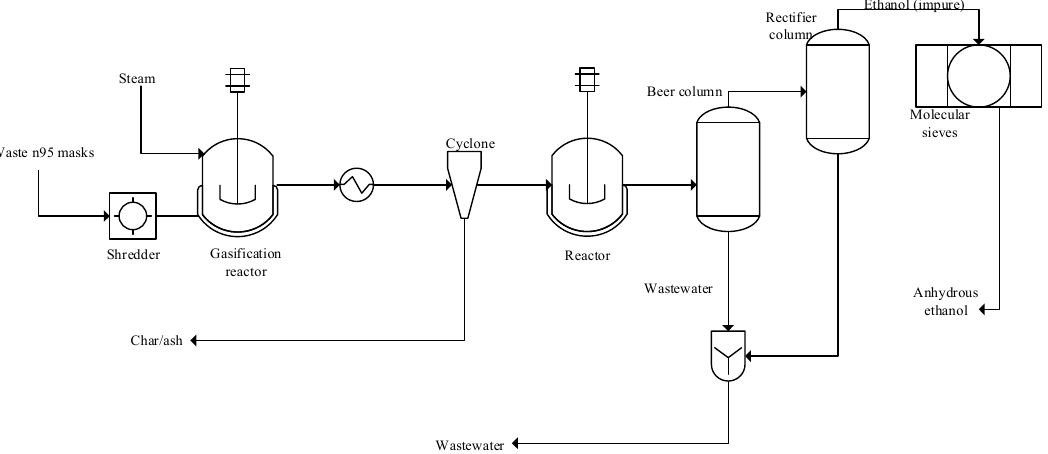
Figure 4. Waste N95 facemask conversion to ethanol via syngas fermentation (scenario iii).